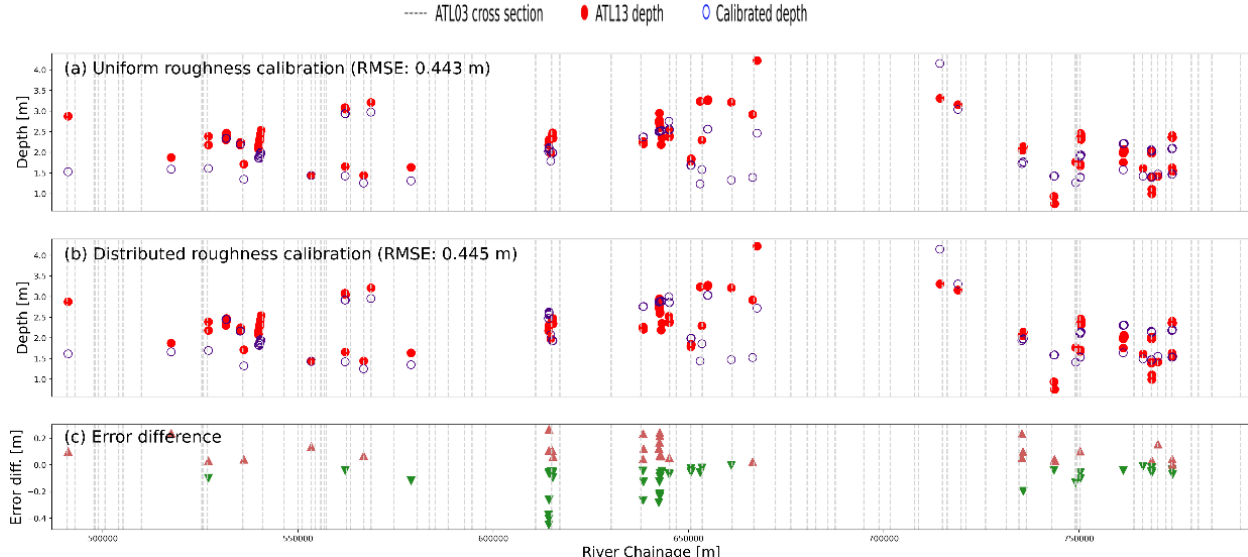
Figure A2. Validation data error for uniform depth calibration (a) , distributed roughness calibration for eight Manning’s roughness values (b) , and the error difference between the uniform calibration and the distributed calibration (c)